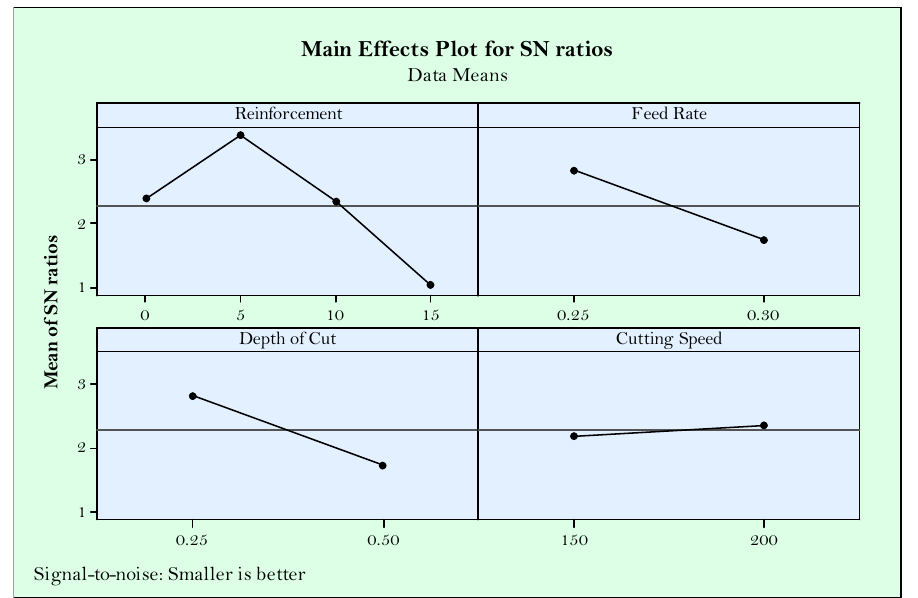
Figure 3. Main effect plots for S/N ratios of surface roughness.